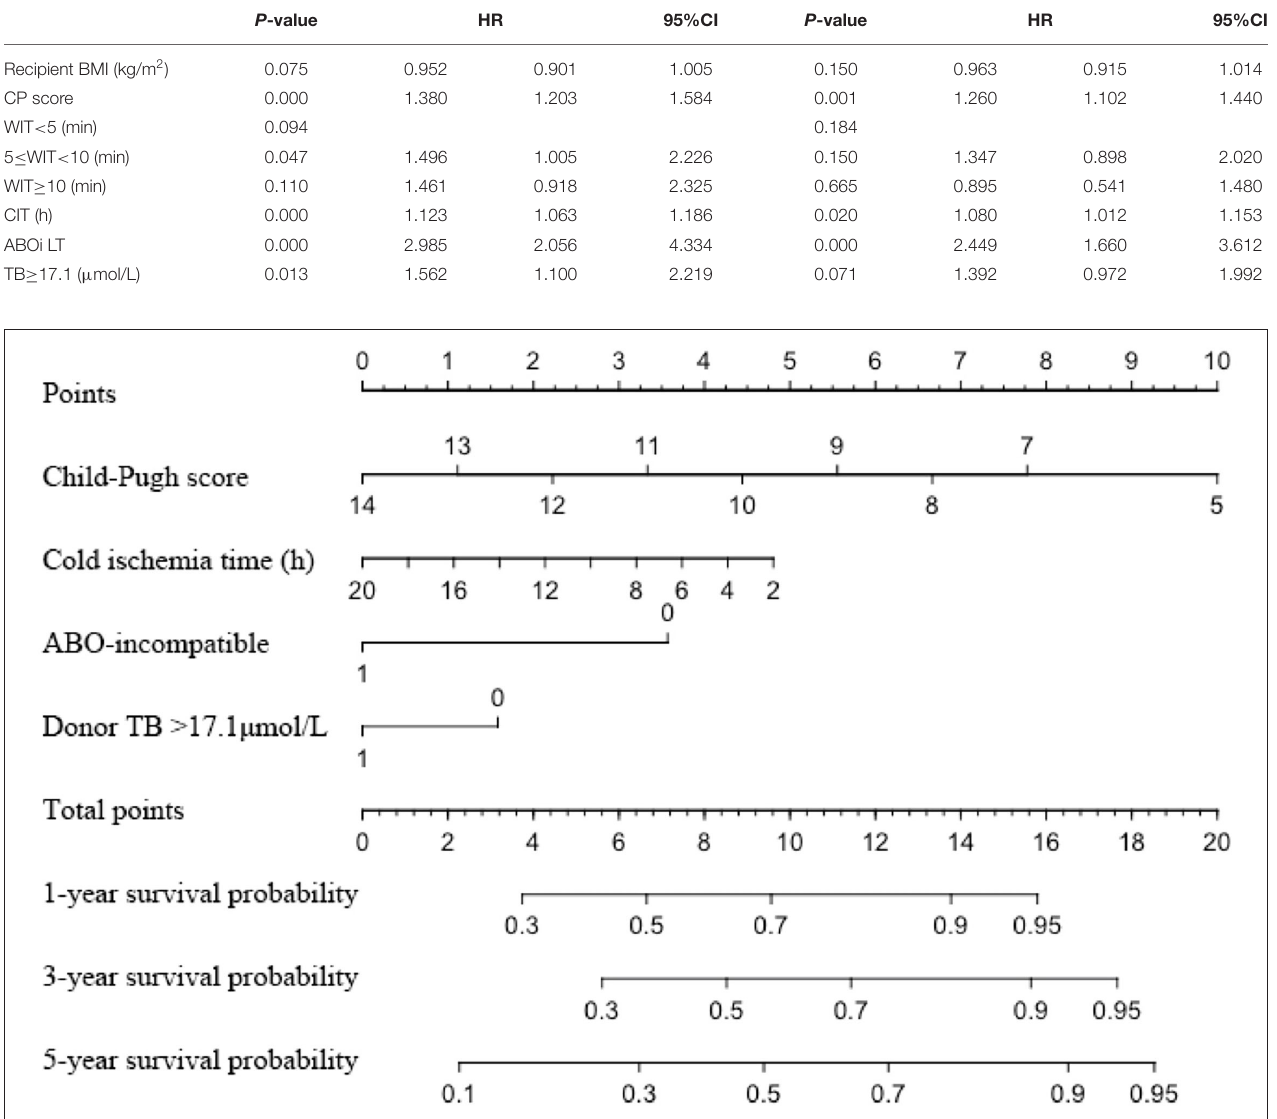
FIGURE 1 | Nomogram for predicting the graft survival of recipients with MELD score over 30. MELD, model for end-stage liver disease; TB, total bilirubin.